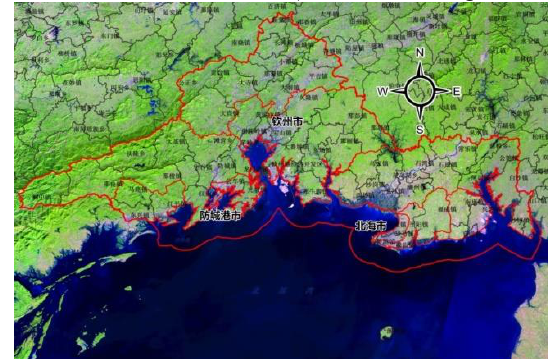
Figure 1. Regional map of Guangxi coastal zone